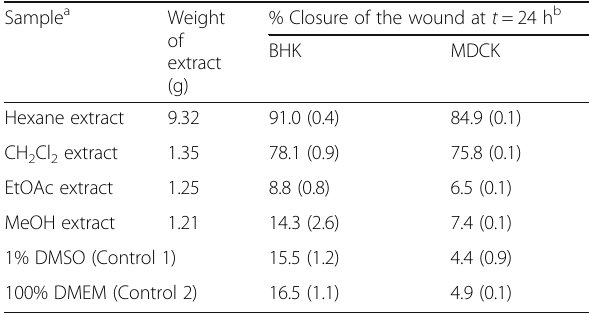
Table 1 Weights of different extracts of F. racemosa bark and SWA results of those extracts with two different cell lines Sample